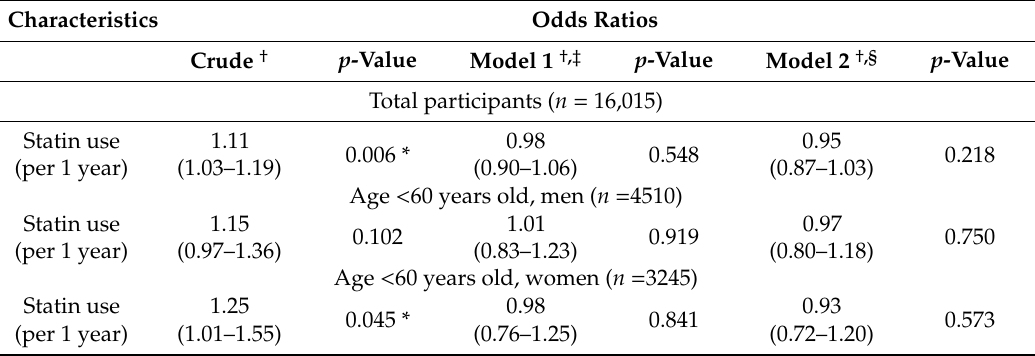
Table 2. Odds ratios (95% confidence interval) for the day of statin use per 1 year in the Bell’s palsy group compared to control group with subgroup analyses according to age and